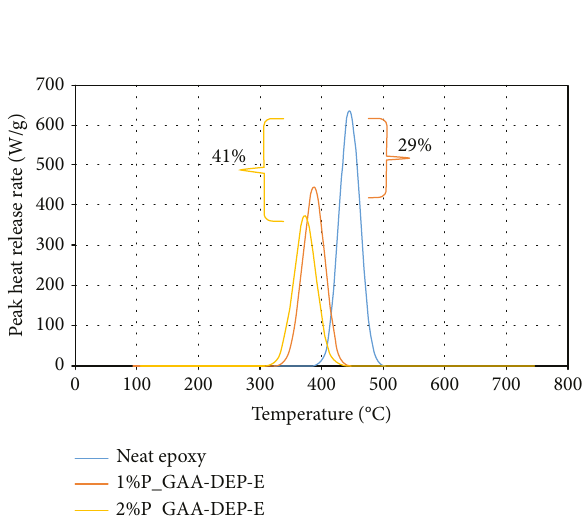
Figure 2: Peak heat release rates for blends of 3,4,5-tri(diethylphosphato)benzanilide with DGEBA epoxy resin.